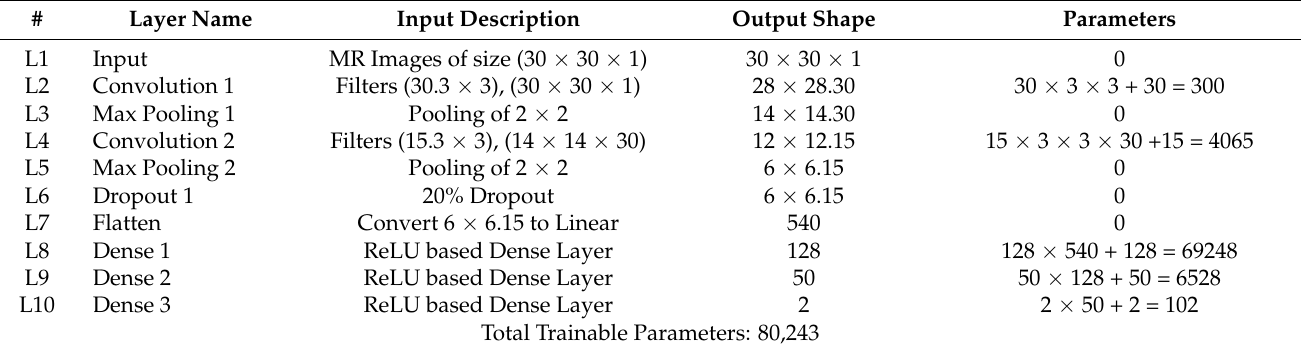
Table 5. Proposed Improved CNN Model 2 for MR Image